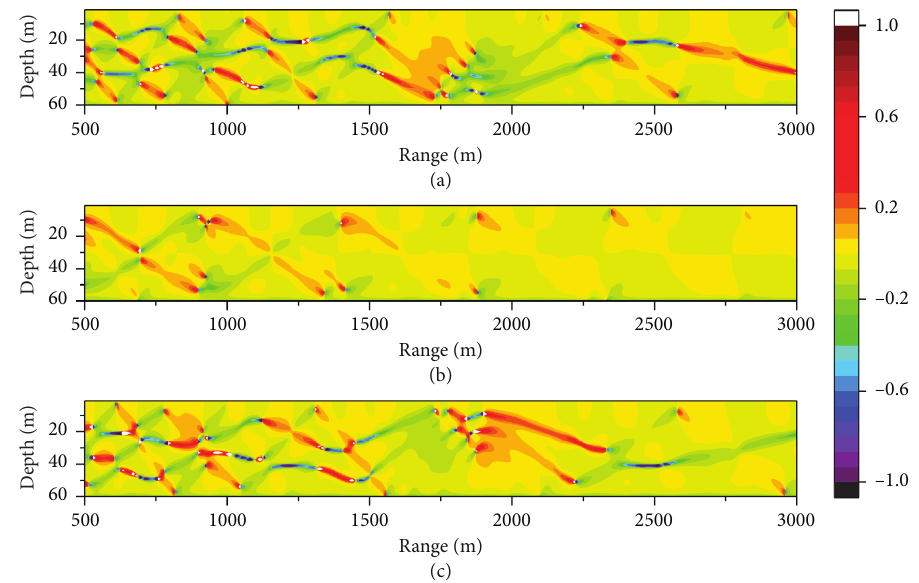
Figure 19: I ∗ h � 30m; (c) h U